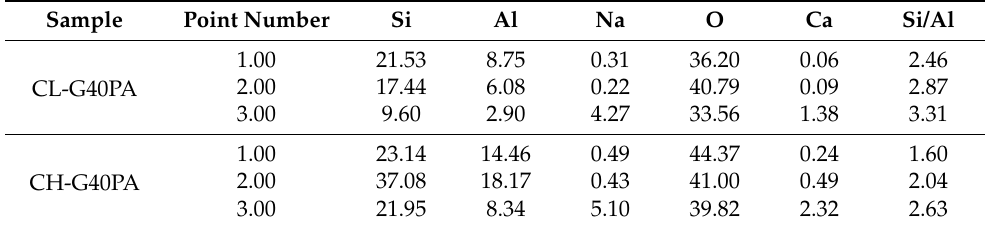
Table 5. Chemical composition and ratios of elements in the selected specimens. Sample Point